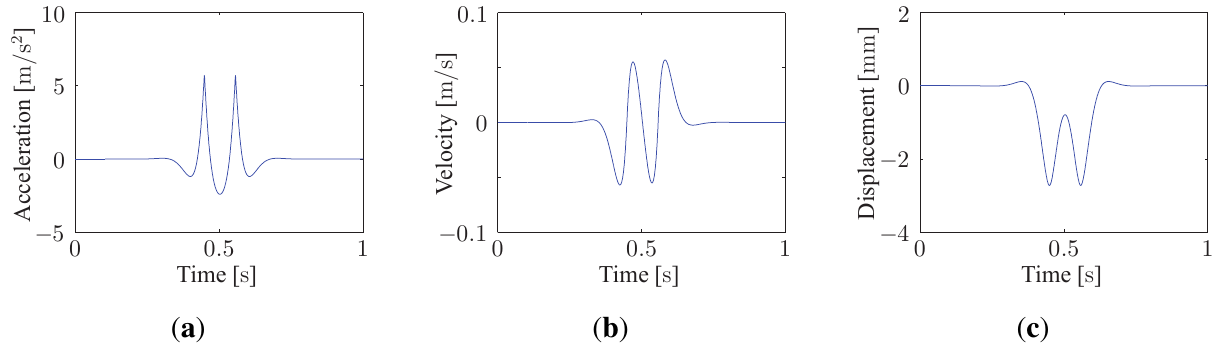
Figure 12. Track deflection due to the passing of a single bogie. ( a ) Acceleration; ( b ) Velocity; ( c )